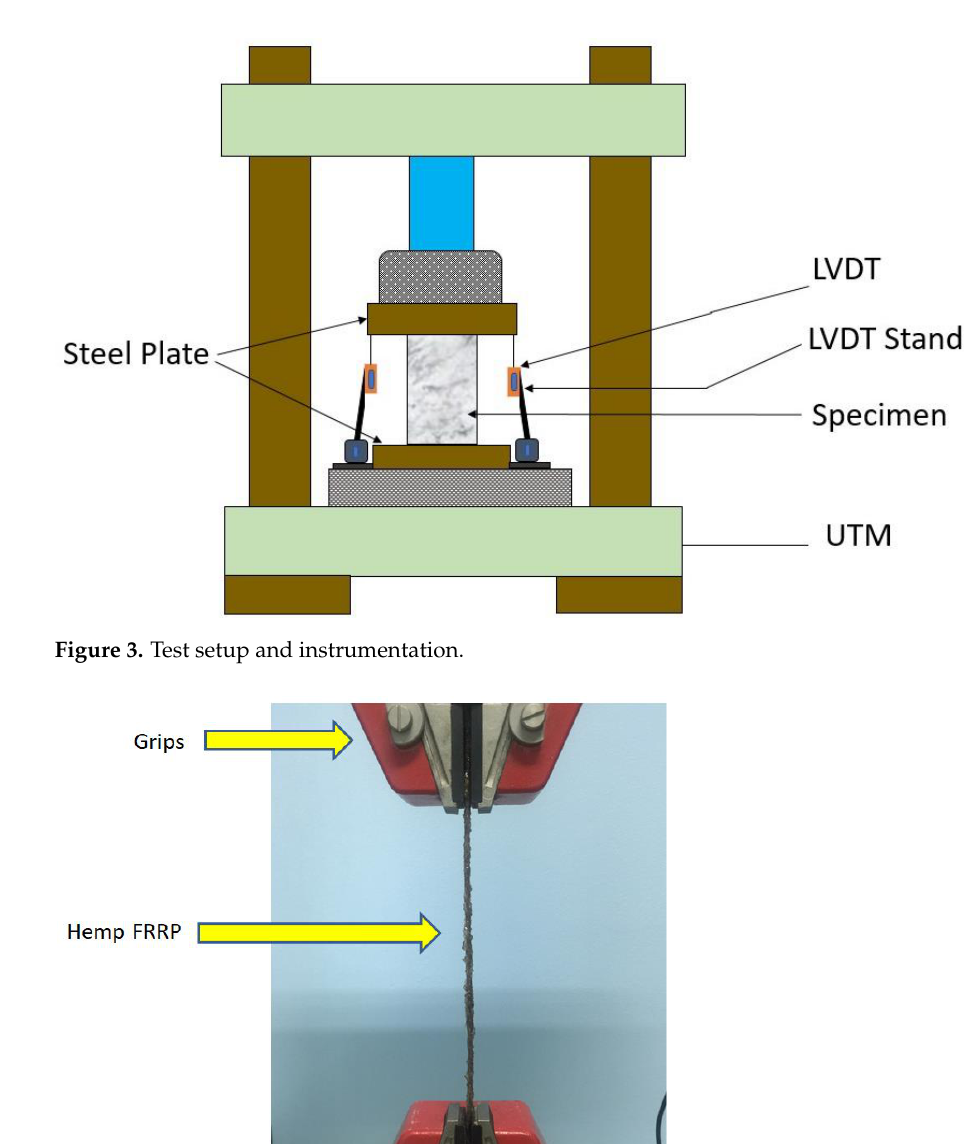
C-0-3H Figure 5. Failure modes of concrete prisms (Group 1). Group 2: Typical failures of Group 2 cylinders are presented in Figure 6. Unlike Group 1 cylinders, Group 2 specimens were constructed by substituting 50% of the natural aggregates with lightweight aggregates. The consequences are reflected in their failure mechanisms, as shown in Figure 6. Foremost, control cylinder C-50-CON failed by crush- ing and splitting like its counterpart cylinder in Group 1. However, its failure cone was